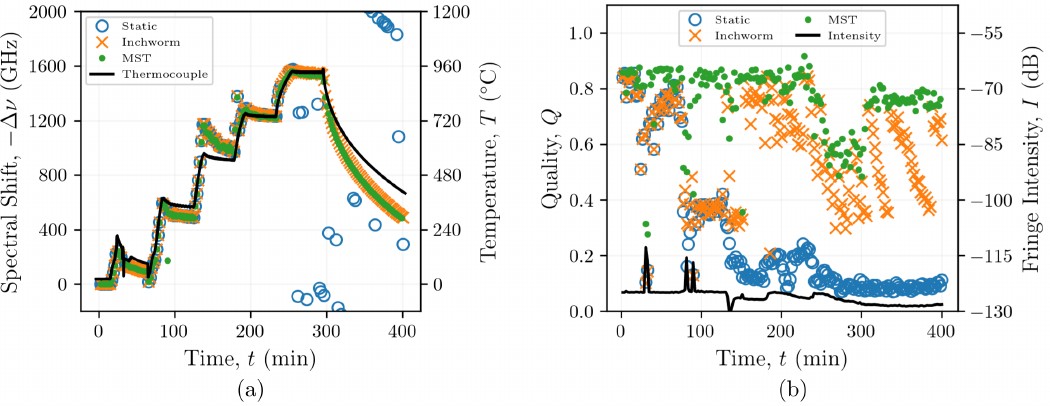
Figure 5. Spectral shifts ( a ) and qualities ( b ) of reconstructions of data from a heated SMF-28 optical fiber using the static reference, inchworm algorithm, and MST post-processing